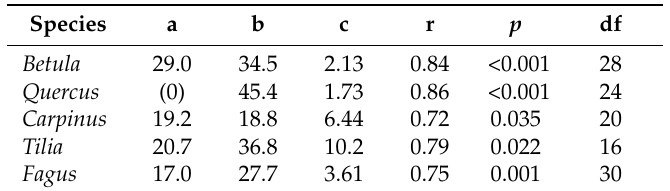
Table 5. Parameters a, b, and c of exponential regression equations of the form y = a + b x c for the dependence of leaf angle on relative height in the crown for the five species. Correlation coefficients r, p -values, and degrees of freedom are also given.